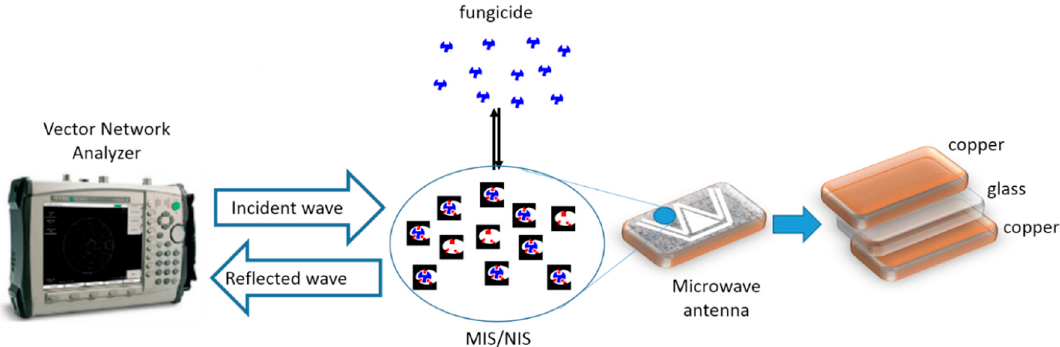
Figure 1. Microwave sensor showing an antenna recovered by a layer of molecularly imprinted silica (MIS) or nonimprinted silica (NIS). The VNA (Vector Network Analyzer) generates a wave between 10 MHz and 20 GHz and records the reflection coefficient ( Γ (f)) at each frequency. The W geometry of the antenna was designed to enhance the microwave